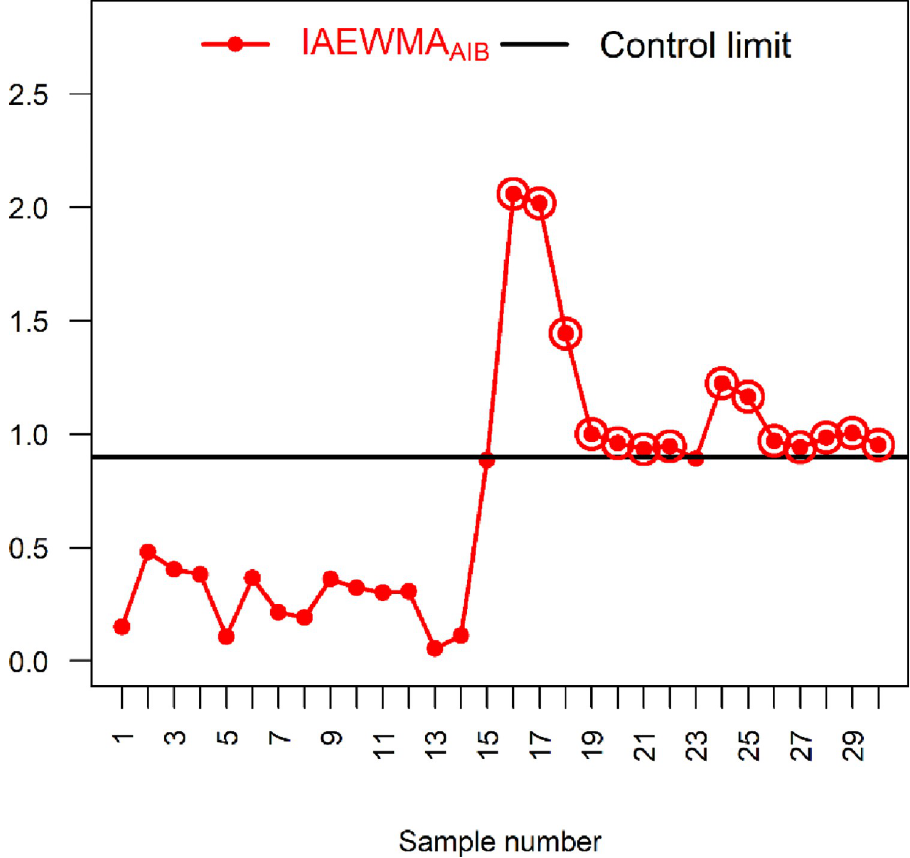
Fig 7. Proposed IAEWMA AIB control chart with real-life data of ground water using ρ = 0.50, λ 1 = 0.2, λ 2 = 0.75, ¼ 0 : 9002 and ARL 0 = h IAEWMA AIB